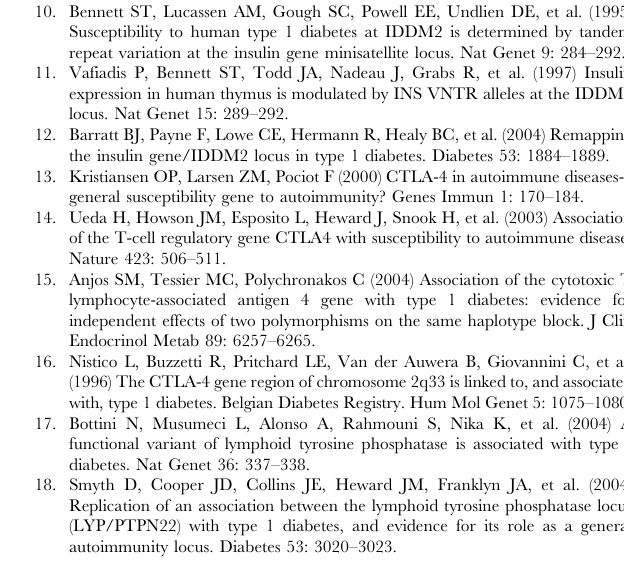
SNP in the region. Recombination rate is overlaid on the figure and the position with respect to genes is shown at the bottom. Table S1 Discovery set P -values and odd ratios are shown for strongest associated SNP in known T1D associated regions. The list of known associated regions was collected from references cited in the references column and shown below. Table S2 P -values and odds ratios of discovery and replication cohort are shown for all SNPs taken forward to replication stage. Combined P -values are shown for all SNPs that had the same direction of effect. P -values were combined using the Fishers combined P -value method implemented in Haploview. NA refers to a different direction of effect and the P -value was never computed. One SNP, rs722988, which failed in the genotyping assay is not shown. Table S3 P -values for the six SNPs highlighted in Table 1 following adjustment for lambdas. (DOC) Text S1 Correlation outcomes of Eigenvectors with known continental